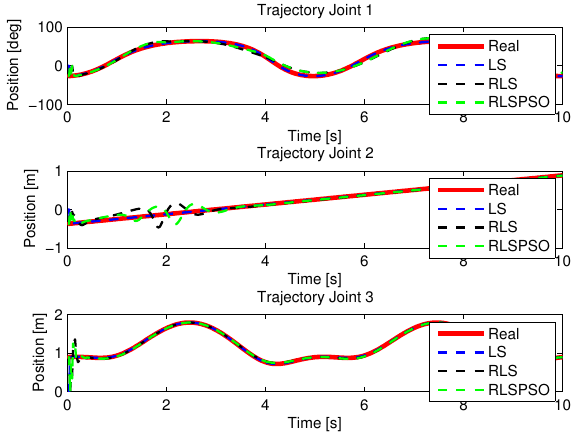
Figure 38. Trajectories